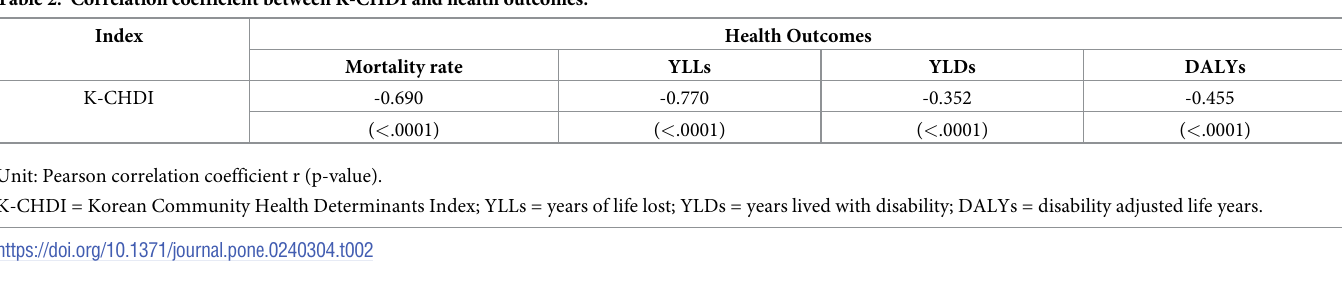
Table 2. Correlation coefficient between K-CHDI and health